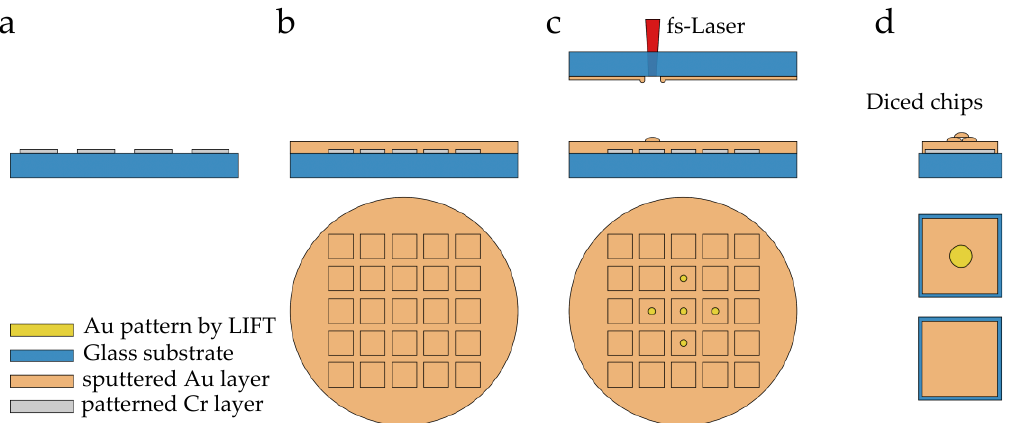
Figure 4. Schematic illustration of LIFT-printed ordered porous gold electrode fabrication: ( a ) sput- tered Cr adhesion layer, ( b ) continuous Au layer and ( c ) LIFT deposition of the Au pattern. Planar Au layer without LIFT deposition was taken as the reference material. ( d ) Square chips with and without porous structures were obtained after dicing.